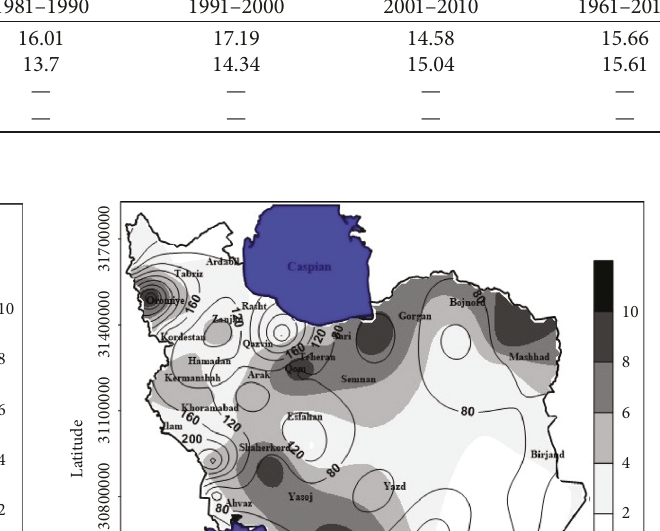
Table 4: The coverage percentage of spatial autocorrelation pattern of Iran’s thunderstorms based on Moran’s I.